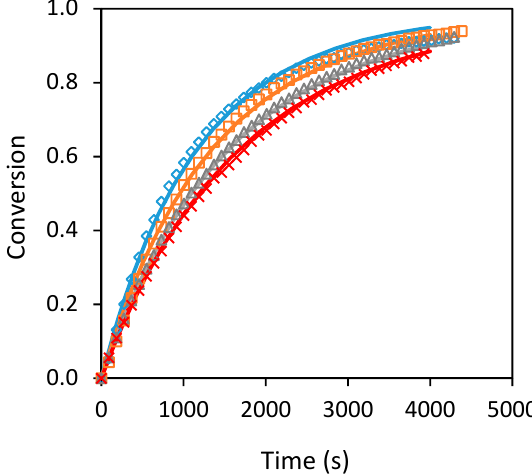
Figure 7. Comparison of experimental (symbol) and simulated (lines) batch conversion profiles collected at varying w mon,0 of 0.05 ( ◊ ), 0.10 ( □ ), 0.20 ( Δ ) and 0.35 (×) at 50 °C with 0.80 wt% V-50 in aqueous solution. Experimental results taken from [26], with simulations generated using the model summarized in Tables 1 and